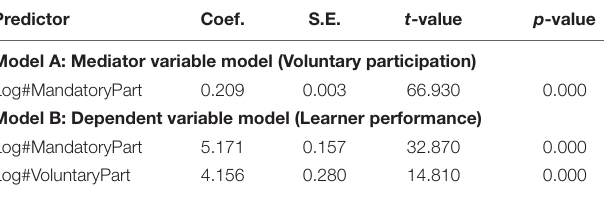
FIGURE 2 | Estimation results of the moderated mediation model. TABLE 4 | Mediation model ( n = 27,767).